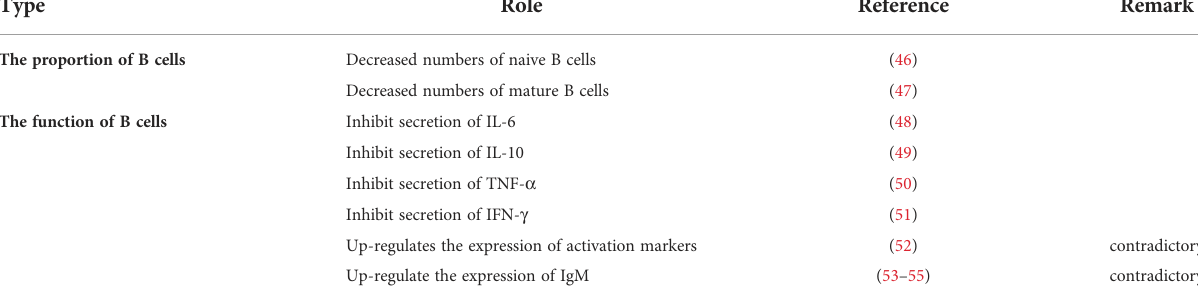
TABLE 3 Effects of n-3 PUFAs supplementation on B cells.